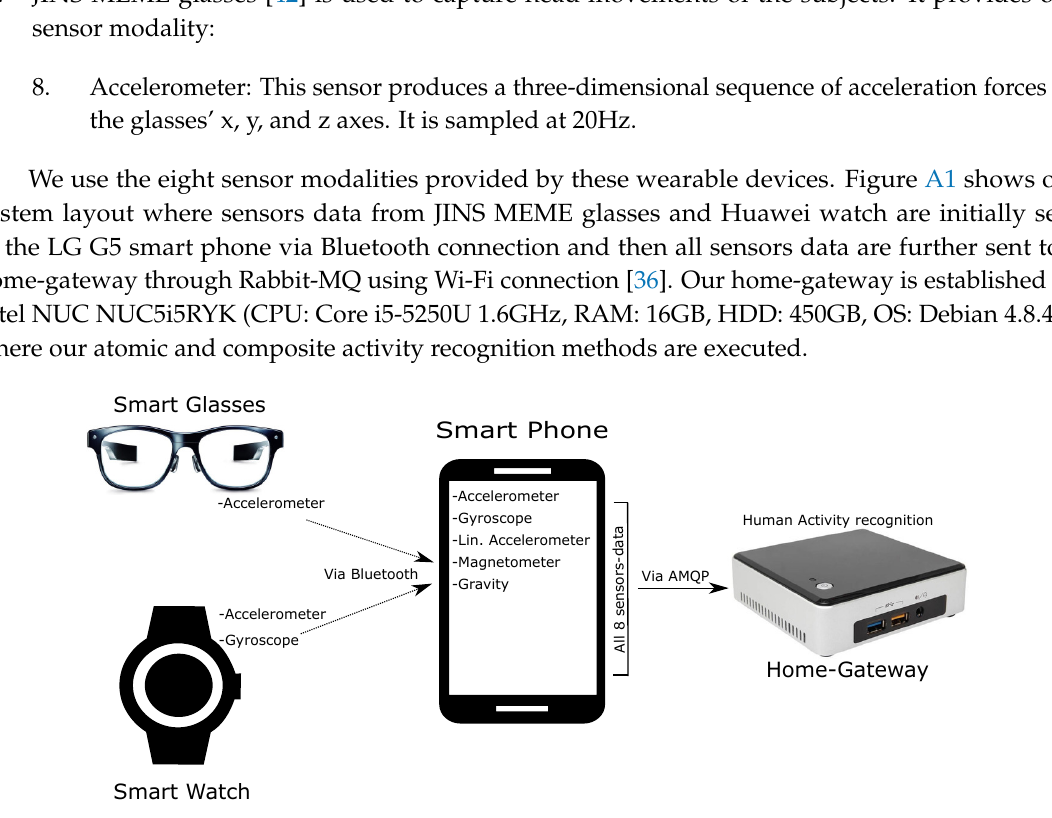
Figure A1. System layout: Our system uses three wearable devices. The sensory data from the smart glasses and the smart watch are firstly sent to smart phone via Bluetooth connection and then all sensory data is sent to home-gateway through Rabbit-MQ using Wi-Fi